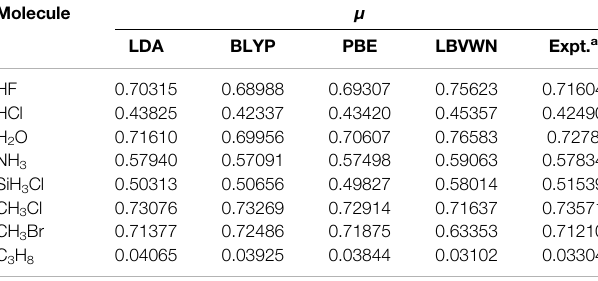
TABLE 2 | Permanent dipole moment of molecules for four XC functionals. All results in a.u. and taken from Mandal et al.